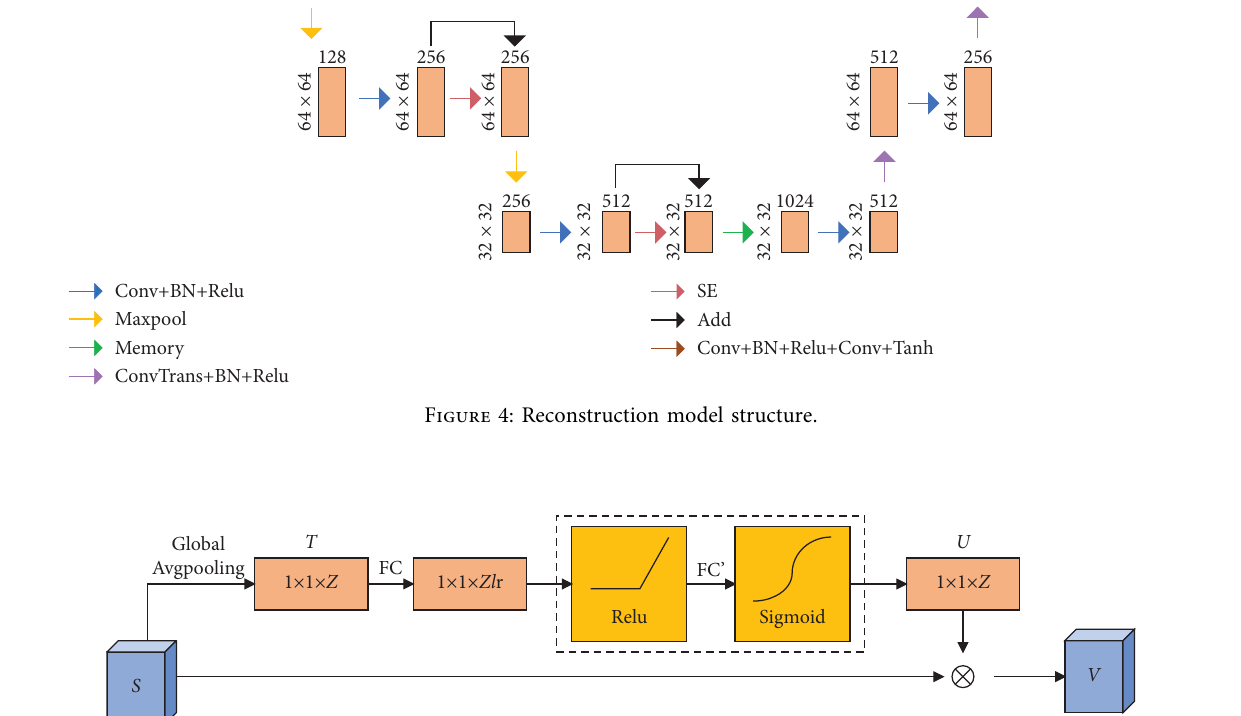
Figure 5: Attention module in reconstruction